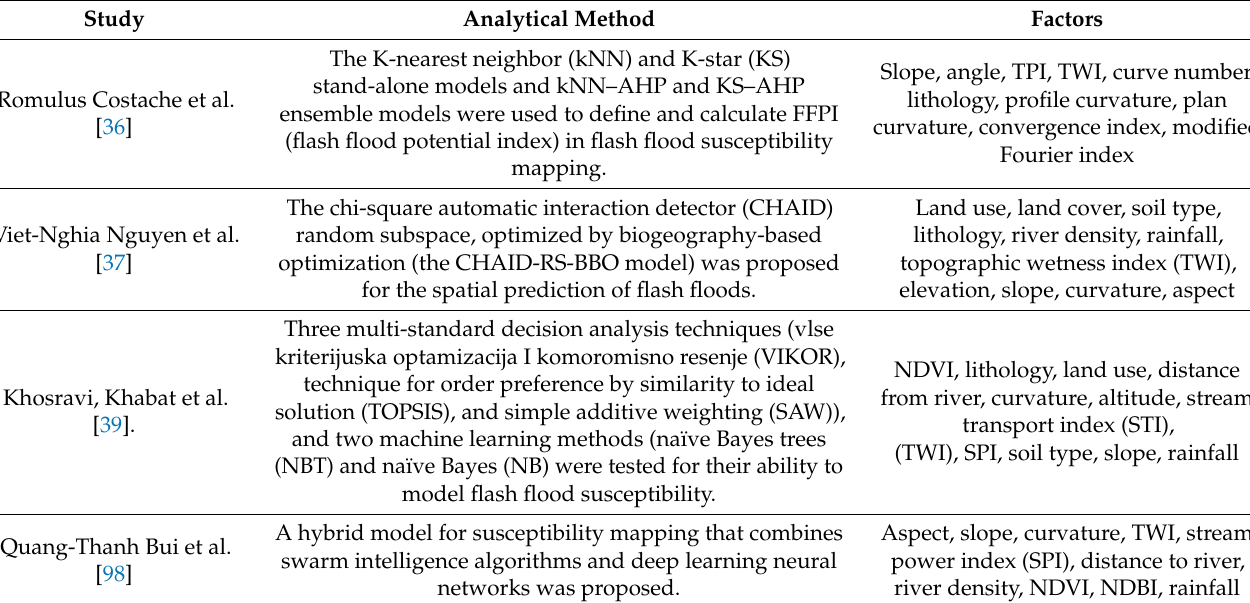
Table 5. For susceptibility mapping of flash